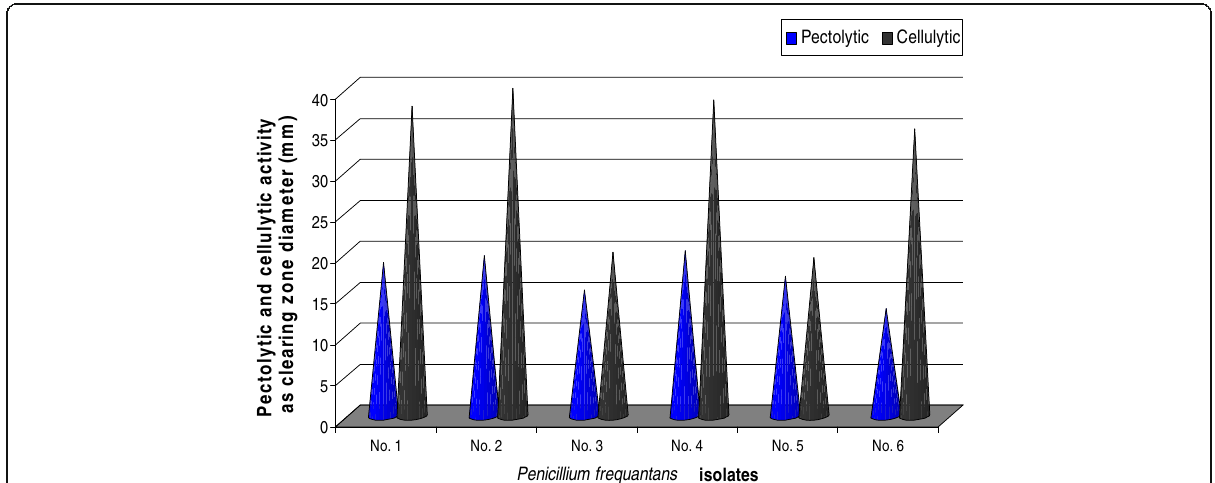
Fig. 4 Screening test of pectinase and cellulase activity of Penicillium frequentans isolates